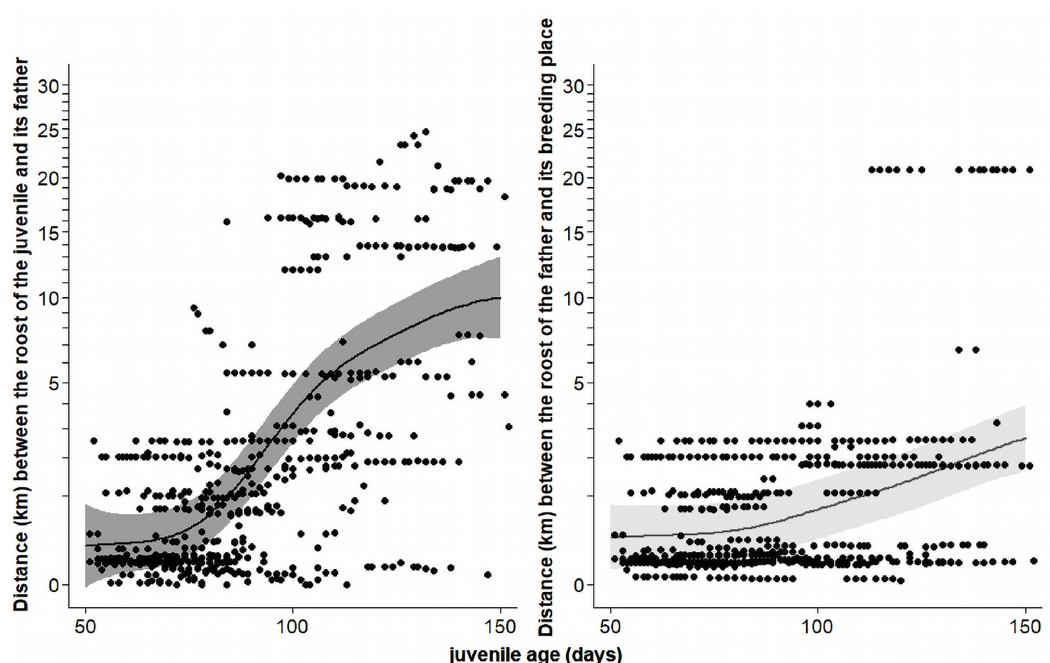
Fig 7. Left panel: Distance between daylight roost of the juvenile and its father in relation to juvenile age. Right panel: distance between daylight roost of the father and its breeding place in relation to juvenile age. The figure is based on the GAMMs presented in Table 3. Dots represent raw data and solid lines the population mean with 95%CrI. The analyses are based on 542 observations of 23 juveniles from 12 broods in 2005.